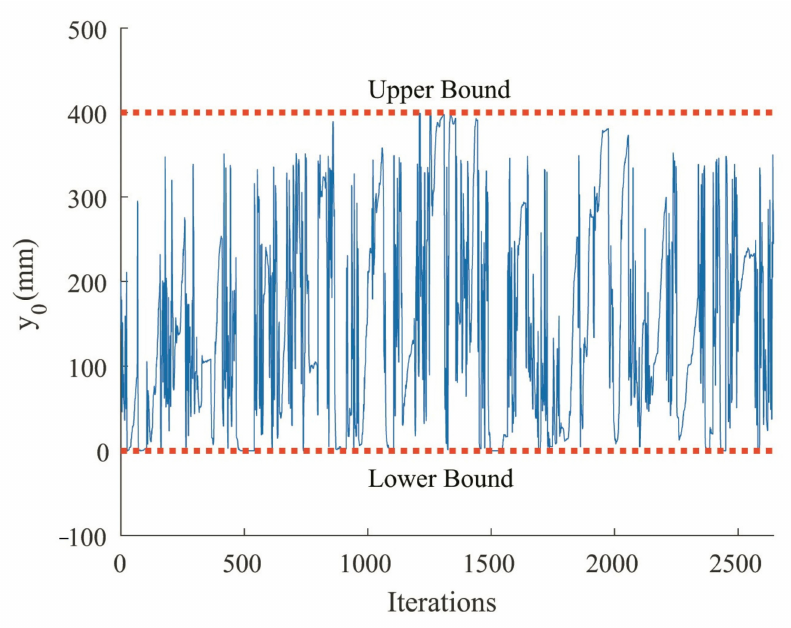
Figure 9. The values of design variable y